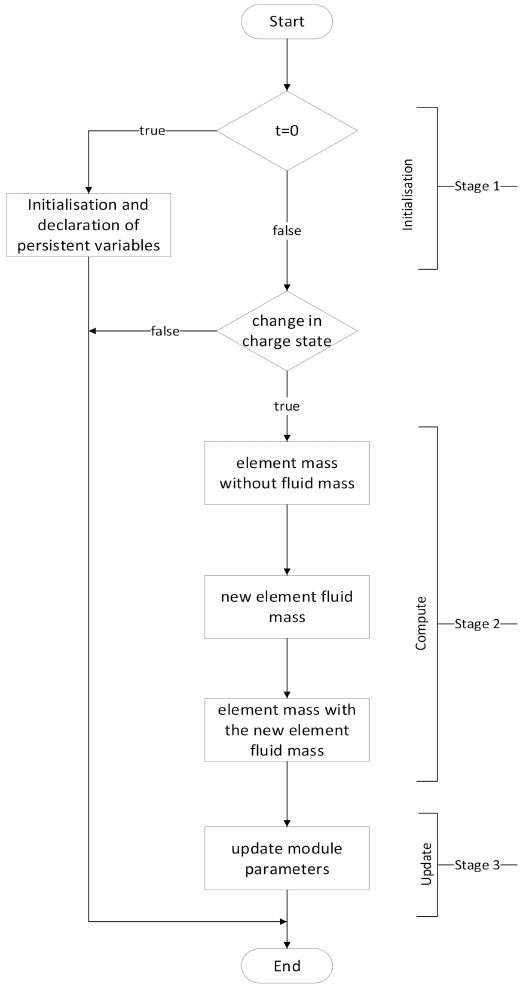
Figure 2. Iterative process for initializing, computing, and updating the change in a blade element mass, and their related